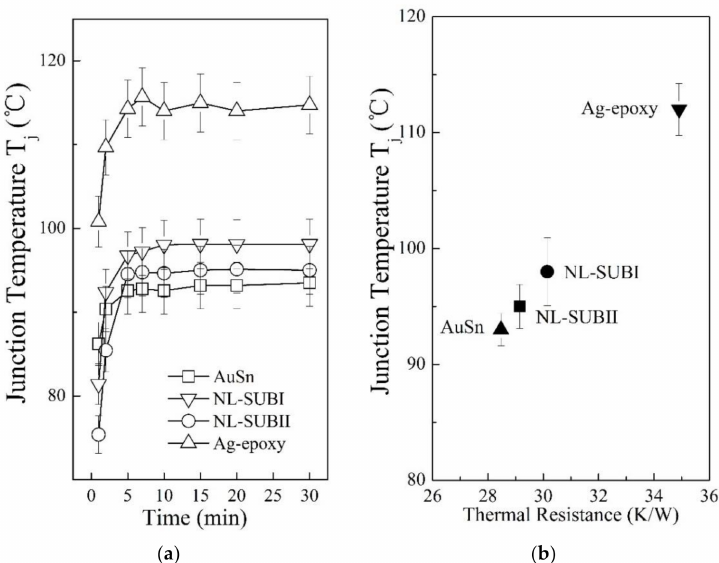
Figure 7. ( a ) The die junction temperature ( T j ) of the devices made by the NL bonding method with different substrates and two conventional die–substrate bonding methods: the open circle symbol ( ) represents the T j data for the device made by NL bonding with substrate type-II, the open (cid:35) downside triangle symbol ( (cid:53) ) represents T j data for the device made by NL bonding with substrate type-I, the open square symbol ( (cid:3) ) represents T j data for the device made by the AuSn bonding with an industrial standard BLT value of 20 ± 2 µ m, the open upside triangle symbol ( (cid:52) ) represents Ag-epoxy bonding with an industrial standard BLT value of 25 ± 2 µ m. ( b ) The relationship between T j and R th : the solid circle symbol ( • ) represents NL bonding with substrate type-I; the solid square symbol ( (cid:4) ) represents NL bonding with substrate type-II; the solid upside triangle ( (cid:78) ) represents AuSn bonding with an industrial standard BLT value of 20 ± 2 µ m; and the solid downside triangle ( (cid:72) ) represents Ag-epoxy bonding with an industrial standard BLT value of 25 ± 2 µ